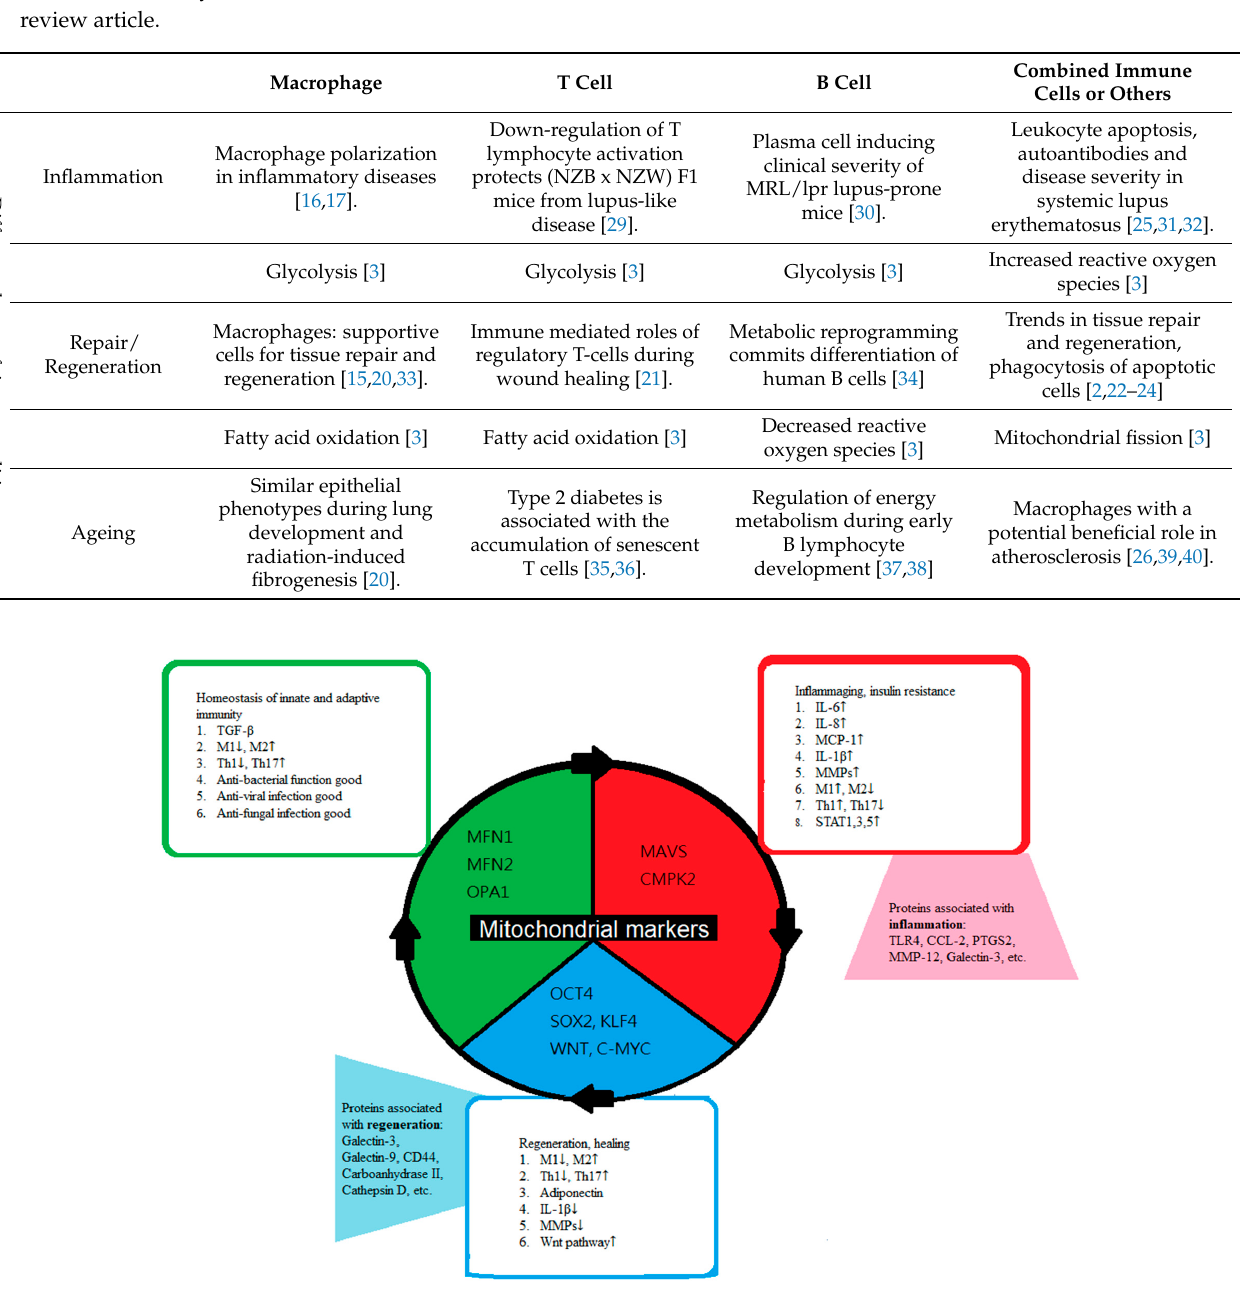
Figure 1. Summary of the cooperation of mitochondria (central circle) in controlling the balance between immune cells in homeostasis (green box), inflammageing (red box), and regeneration (blue box) status. Figure legends: immune cells or tissue cells in either homeostasis (green box), ageing (red box), and regeneration (blue box) status have different phenotypes and mitochondrial markers, which represent the interactions between the cell itself and its environment. The mitochondrial markers represent different mitochondrial DNA activation in each status, homeostasis (green), ageing (red), and regeneration (blue). The proteins shown inside the hexagonal boxes could be either found in regenerative status or in the inflammatory status, respectively. Abbreviations: TGF-beta, transforming growth factor beta; MFN1, mitofusin-1; MFN2, mitofusin-2; OPA1, optic atrophy-1; MAVS, mitochondrial antiviral-signaling protein; CMPK2, cytidine/uridine monophosphate kinase 2; OCT4, octamer-binding transcription factor 4; SOX2, SRY-Box transcription factor 2; KLF4, Kruppel like factor 4; C-MYC, cellular- Myelocytomatosis; MCP-1, monocyte chemoattractant protein-1; MMP, matrix metallopeptidases; STAT, signal transducer and activator of transcription; CCL-2, chemokine (C-C motif) ligand 2; PTGS2, prostaglandin-endoperoxide synthase